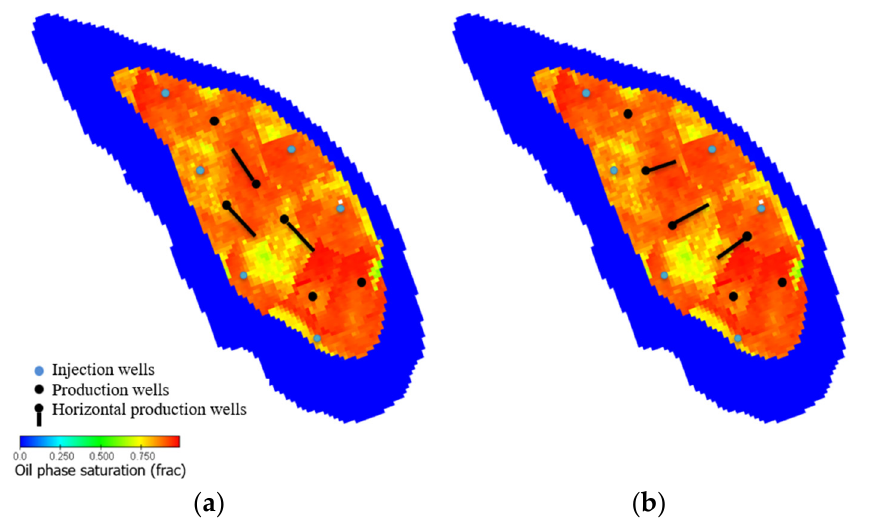
Figure 7. Development strategies: ( a ) Option 1 ( b ) Option